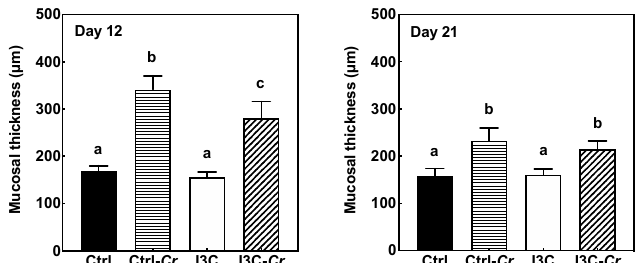
Figure 4. I3C reduces mucosal thickness at day 12 but not day 21 post-infection. Colon tissue was collected on day 12 and day 21 after infection and processed for H&E-staining. Mucosal thickness was measured on well-oriented crypts and 12 or more individual measurements were averaged for each mouse. Results were expressed as mean +/ − SD (n = 8). Ctrl: control diet; Ctrl- Cr : control diet, Cr -infected; I3C: I3C diet; I3C- Cr : I3C diet, Cr -infected. Significant differences ( p < 0.05) between groups are identified by different letters.